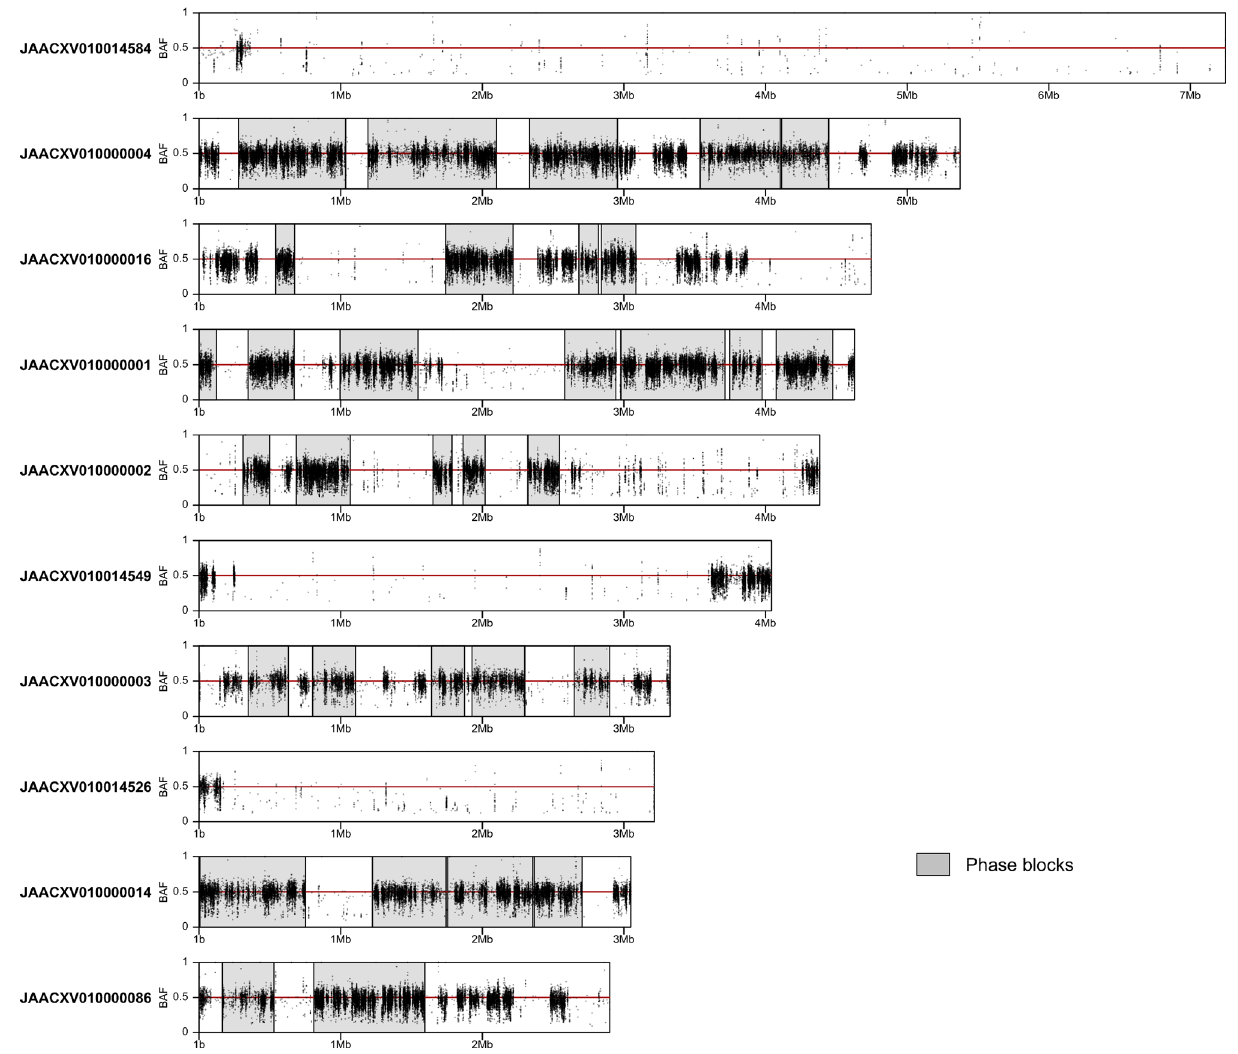
Figure 1. Phase blocks and B-allele frequency (BAF) of single-nucleotide variants (SNVs) in the 10 largest scaffolds of the RPW pseudo-haplotype1 assembly. Phased regions are shown as gray highlighted boxes and SNVs as black dots. Regions with white background represent unphased segments of the genome where both pseudo-haplotype assemblies are identical. SNVs in a diploid genome are expected to display BAF values of ∼